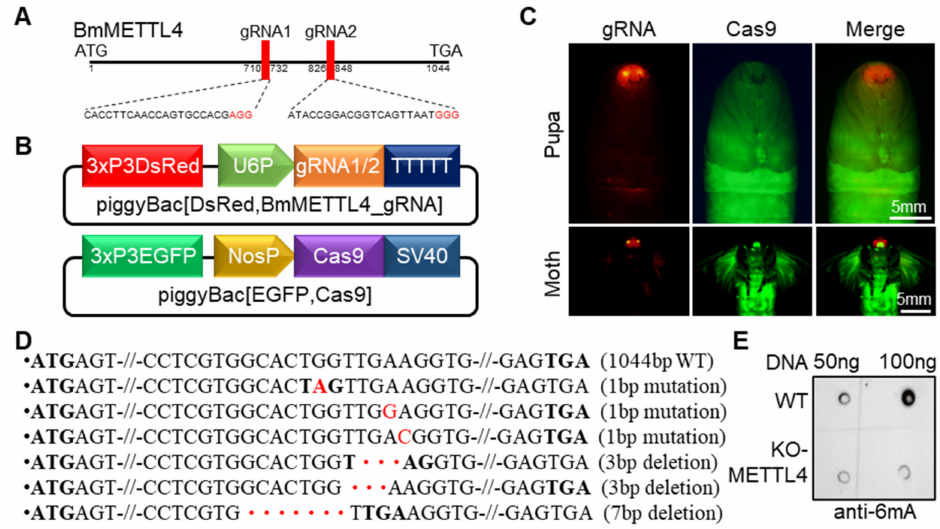
Figure 1. CRISPR-Cas9 system induced the mutation of BmMETTL4. ( A ) A schematic diagram of the BmMETTL4 gene structure and gRNA-target sites. ( B ) Plasmid construction for generation of the transgenic silkworm. ( C ) Positive transgenic silkworms co-expressing gRNAs and Cas9. The positive silkworm pupa and moth were screened under RFP fluorescence (red) and GFP fluorescence (green), respectively. Scale bar is 5 mm. ( D ) PCR-based amplification and sequencing of regions targeted by gRNAs in KO-METTL4 and WT silkworms. The nucleotides labeled in red were replacement, the dots in red were depleted nucleotides, and the bold nucleotides were stop codon. ( E ) Genomic DNAs isolated from the embryos of KO-METTL4 and WT silkworms were subjected to dot blot